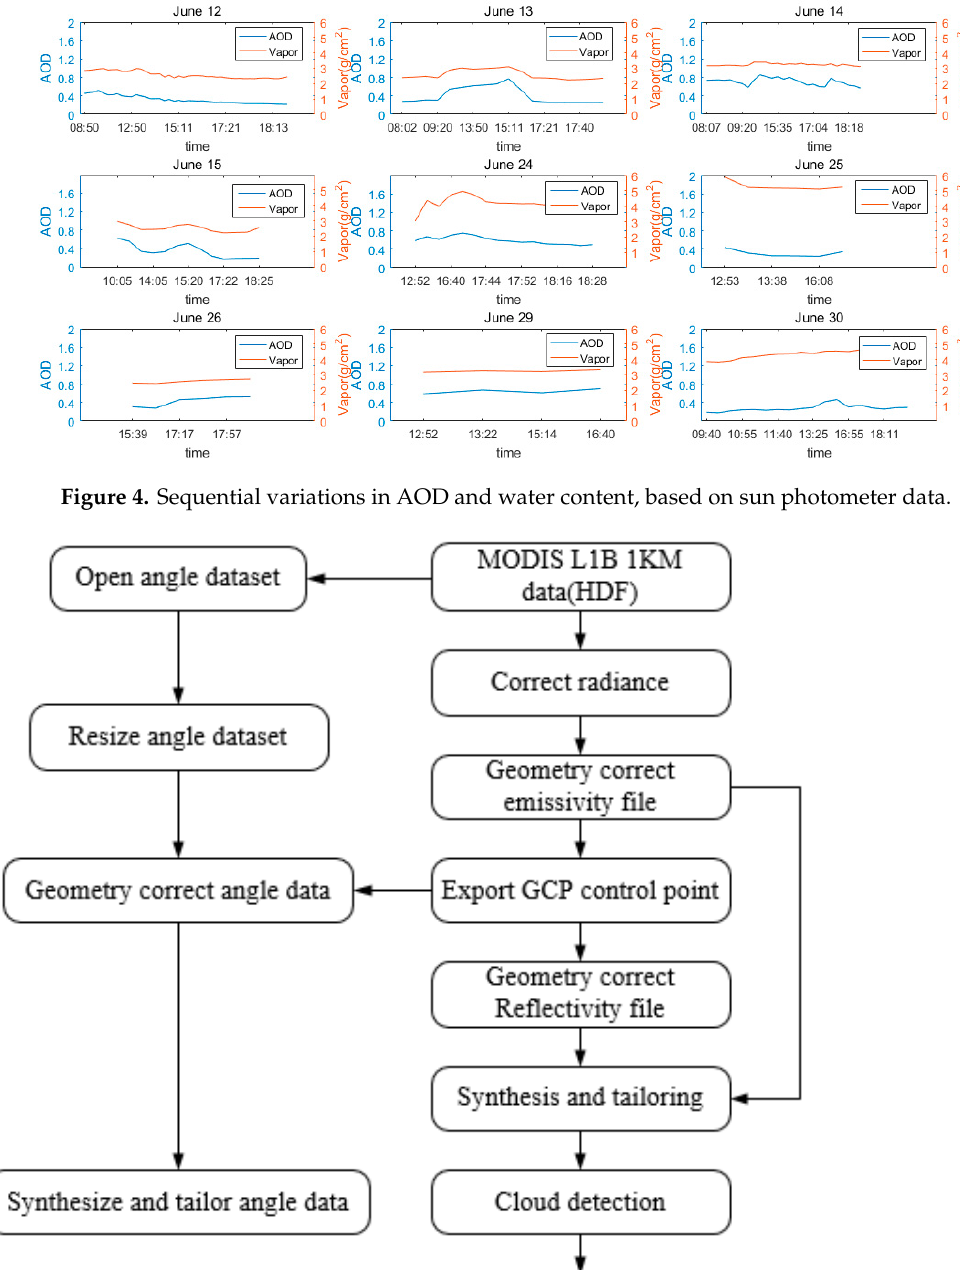
Figure 4. Sequential variations in AOD and water content, based on sun photometer data.